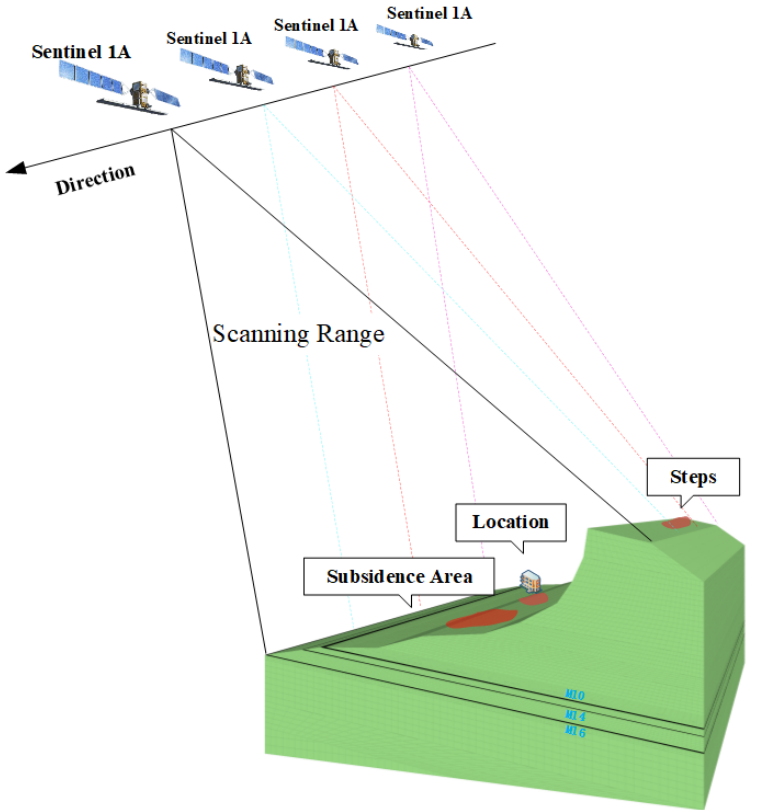
Figure 8. Schematic diagram of satellite shooting and numerical calculation model in mining